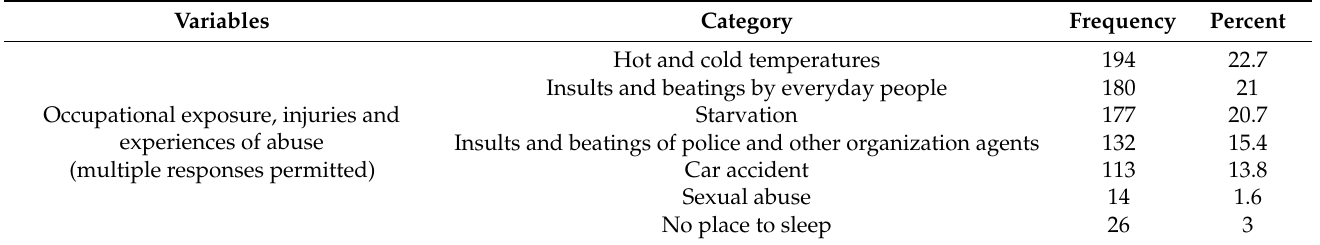
Table 3. Occupational exposure, injuries, and experiences of abuse faced by street children in six provinces of Iran ( n = 856).